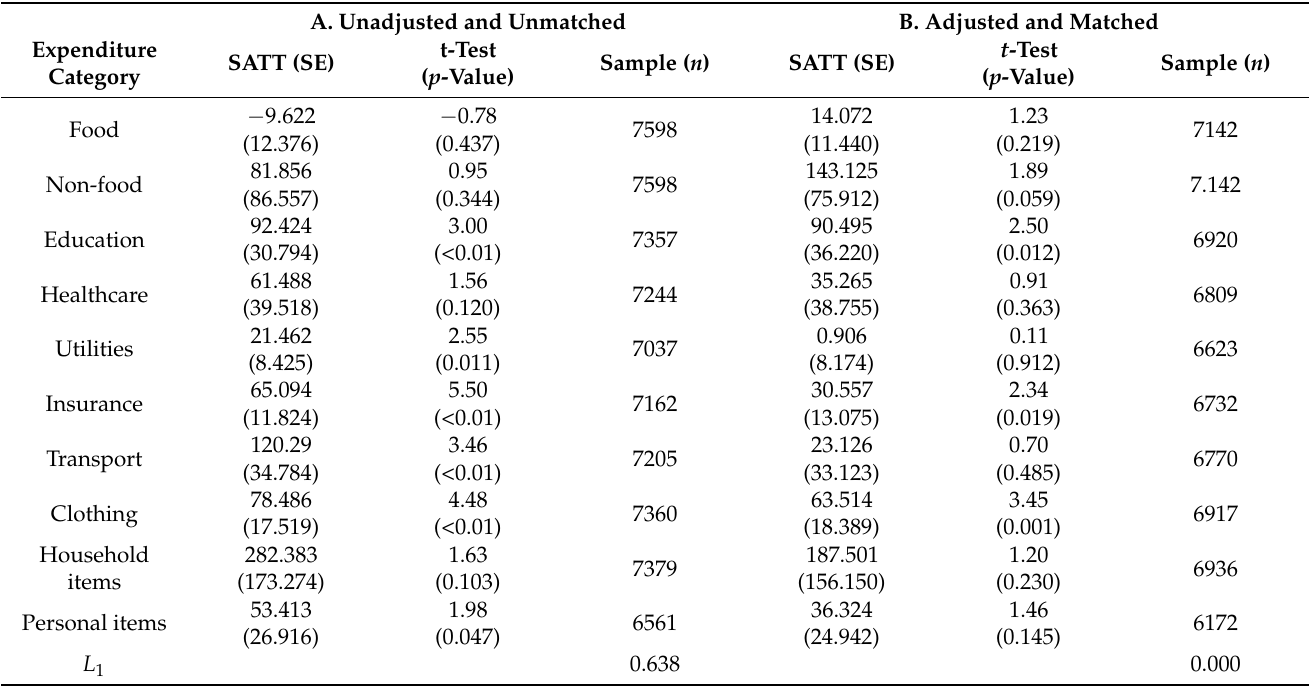
Table 5. Effect of decision-making power on monthly per capita household expenditure